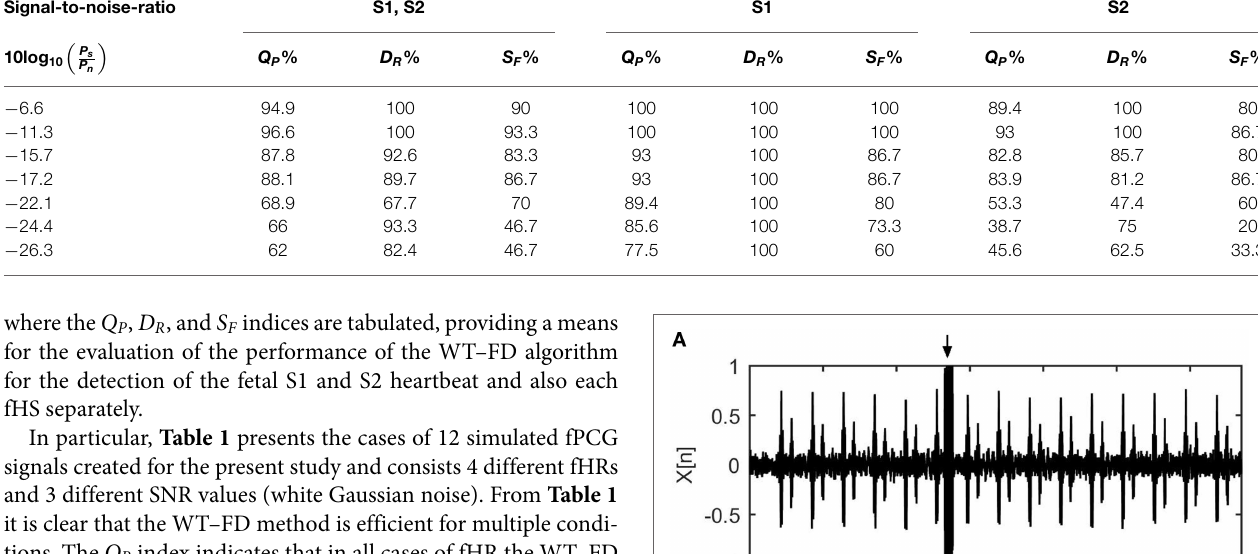
TABLE 2 | Performance of the wavelet transform–fractal dimension filter for signals of PhysioBank. Signal-to-noise-ratio